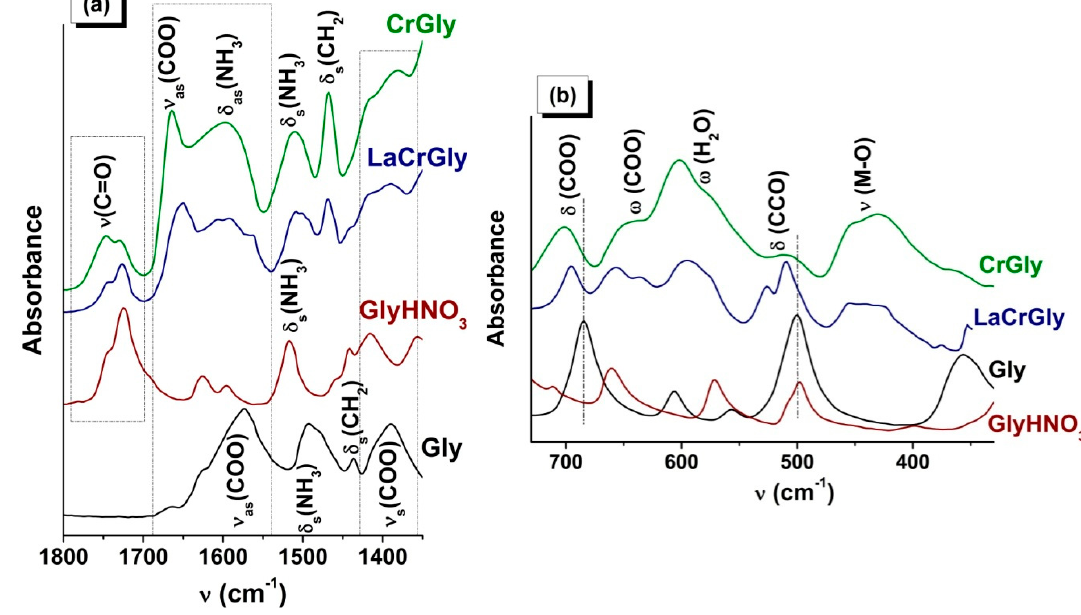
Figure 2. ( a ) ATR FTIR spectra of Gly, GlyHNO 3 , CrGly, and LaCrGly. ( b ) The region of deformational vibrations of the COO and CCO groups.